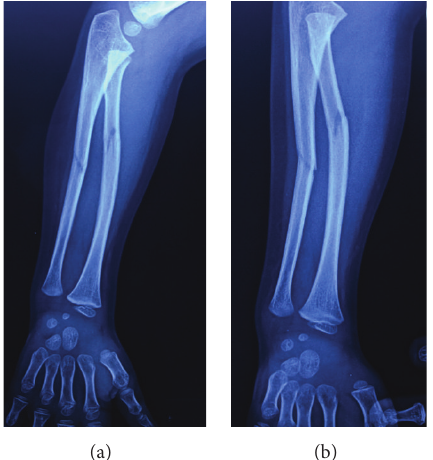
Figure 1: Oblique forearm radiographs taken in outside clinic revealed both bone forearm fractures and no anterior displacement of radial head.